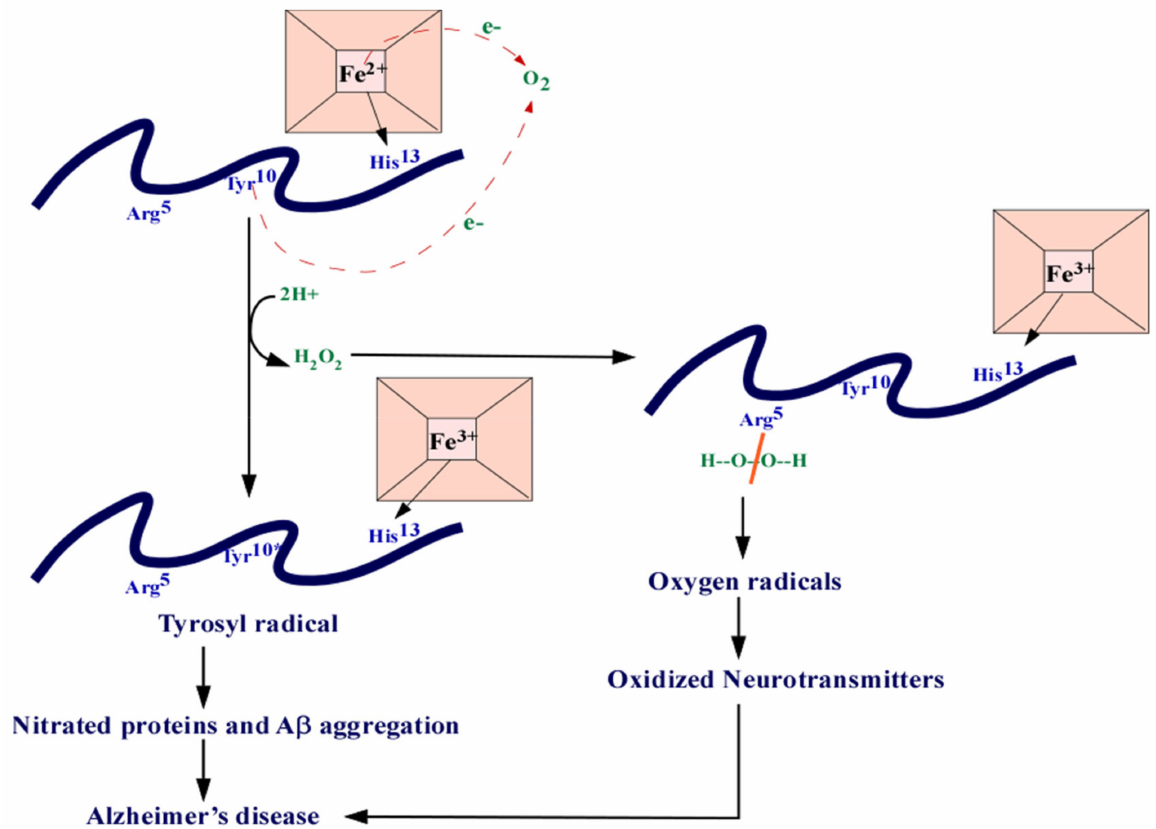
Figure 4. The heme-A β complex. Heme can bind to A β at the His13 residue. The residues can donate one electron each which reduces O2 into H202. The Arg5 residues can split the H 2 O 2 and generate oxygen radicals that are responsible in the nitration of proteins. The ROS can also cause oxidized neurotransmitters. Abbreviations: amyloid beta (A β ), arginine (Arg), tyrosine (Tyr), histidine (Hys), iron (Fe), electron